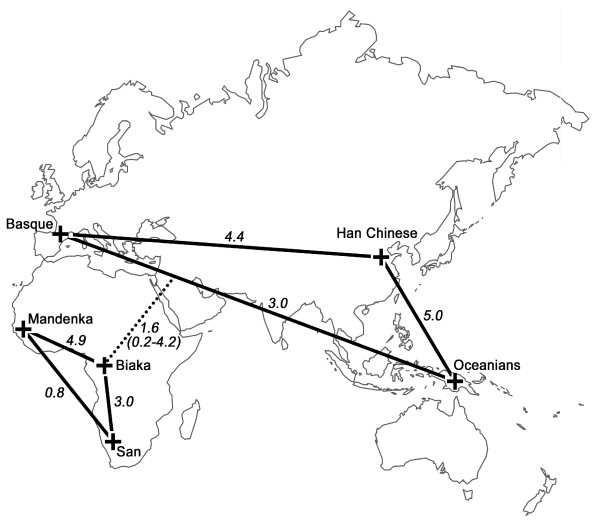
Geographic representation of population migration rates Nm. Mean and range of Nm are provided for African/non-African population pairs.